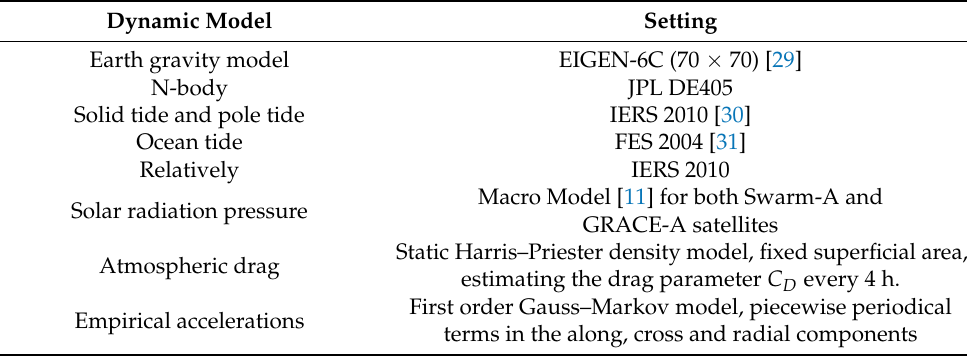
Table 2. Parameter settings of dynamic